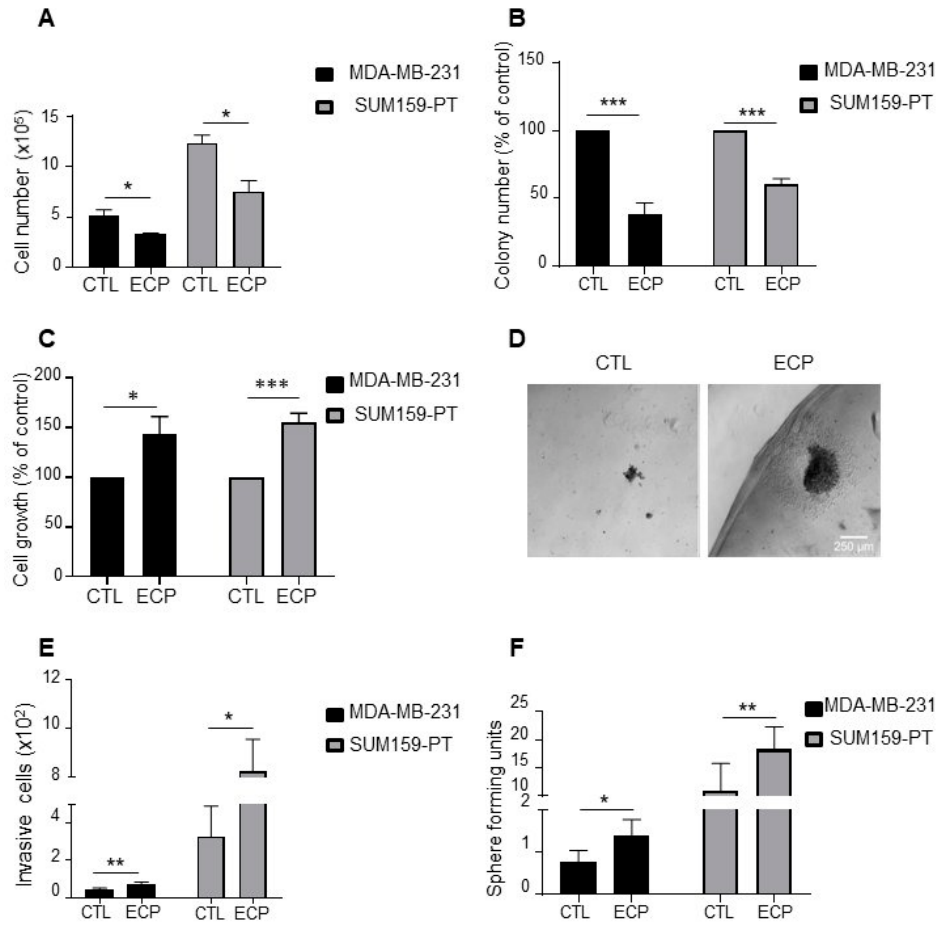
Figure 1. Phenotype characterization of TNBC persistent cells. MDA-MB-231 cells were treated with 8 nM epirubicin and 40 nM cyclophosphamide for 48 h, and then with 1 nM paclitaxel for another 48 h. SUM159-PT cells were treated with 40 nM epirubicin and 200 nM cyclophosphamide for 48 h and then with 2 nM paclitaxel for another 48 h. After drug treatment (ECP), cells were maintained in culture for 4 days to mimic post-therapy scenario. ( A ) Cell count under 2D conditions with a hemocytometer four days after treatment. ( B ) Clonogenic growth. Four days after ECP treatment, cells were harvested and cultured in medium containing 10% FCS for 7 days. Colony formation was evaluated after crystal violet staining. ( C , D ) Cell growth in Matrigel. Four days after ECP treatment, cells were seeded in a mix solution of media containing 1% FCS and Matrigel (v:v, 1:1) to form a droplet, and then cultured in media containing 10% FCS for 10 days. At the end of culture, cells were extracted from Matrigel and counted with a hemocytometer. ( C ) Cell growth quantification and ( D ) Illustration of cells cultured in Matrigel. Scale bar is 100 µ m. ( E ) Four days after treatment, MDA-MB-231 and SUM159-PT cells were seeded in the top of Boyden microchambers precoated with Matrigel. Invasive cells were counted following 24 h of culture. ( F ) Sphere formation of persistent cells. Sphere forming units, calculated as the number of spheres over the number of initially seeded cells. Quantitative graphics correspond to at least 3 independent experiments and the illustrations are representative of 3 independent experiments. *, p <0.05; **, p < 0.01; ***, p < 0.001. Unpaired Student t -test.